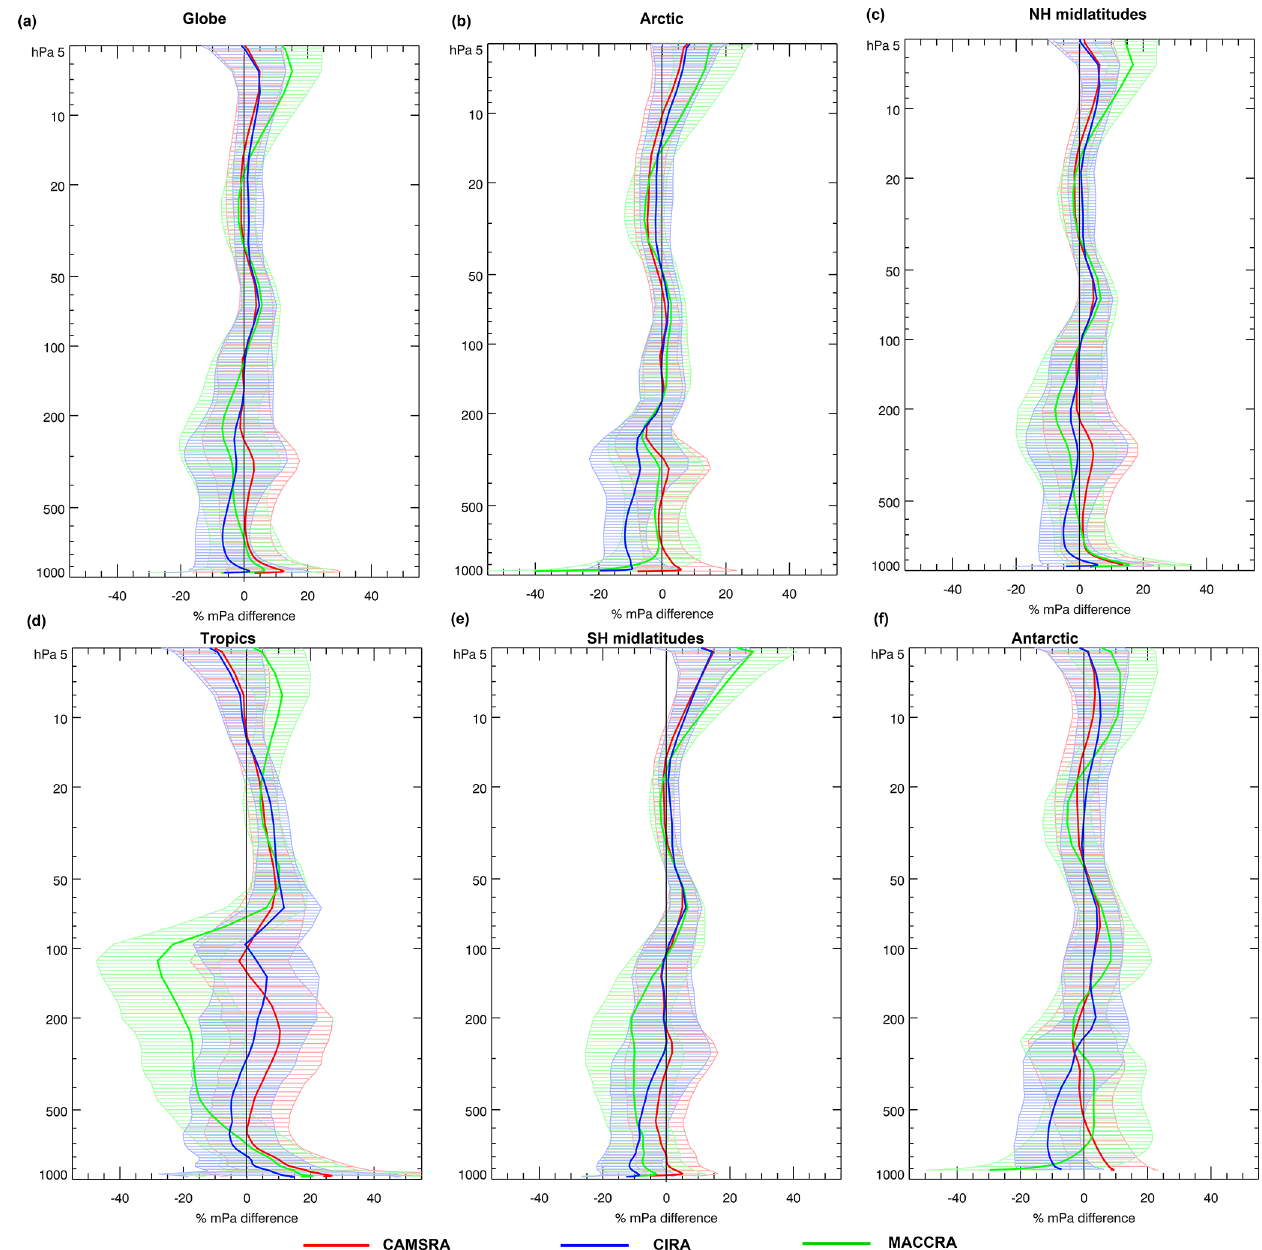
Figure 9. Mean relative O 3 bias in % between CAMSRA (red), CIRA (blue), MACCRA (green) and ozone-sondes averaged over (a) the globe, (b) Arctic, (c) NH midlatitudes, (d) tropics, (e) SH midlatitudes and (f) Antarctic. The shaded areas show plus or minus 1 standard deviation. For CAMSRA and CIRA the average is calculated over the period 2003–2016, and for MACCRA the average is calculated only for